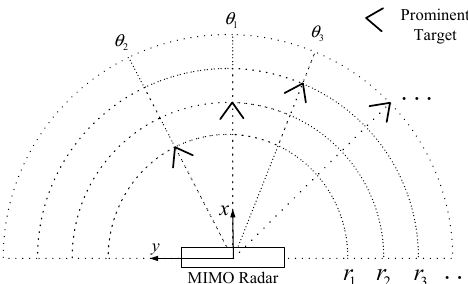
Figure 3. Sketch map of the prominent targets. Firstly, the MIMO radar transmits and receives the wideband signals. After taking pulse compression, MN channels of compressed signals can be obtained. After, K peaks corresponding to every prominent target for each channel are extracted. From (4), the ( ) phase components of the , th m n peak of a prominent target can be expressed as